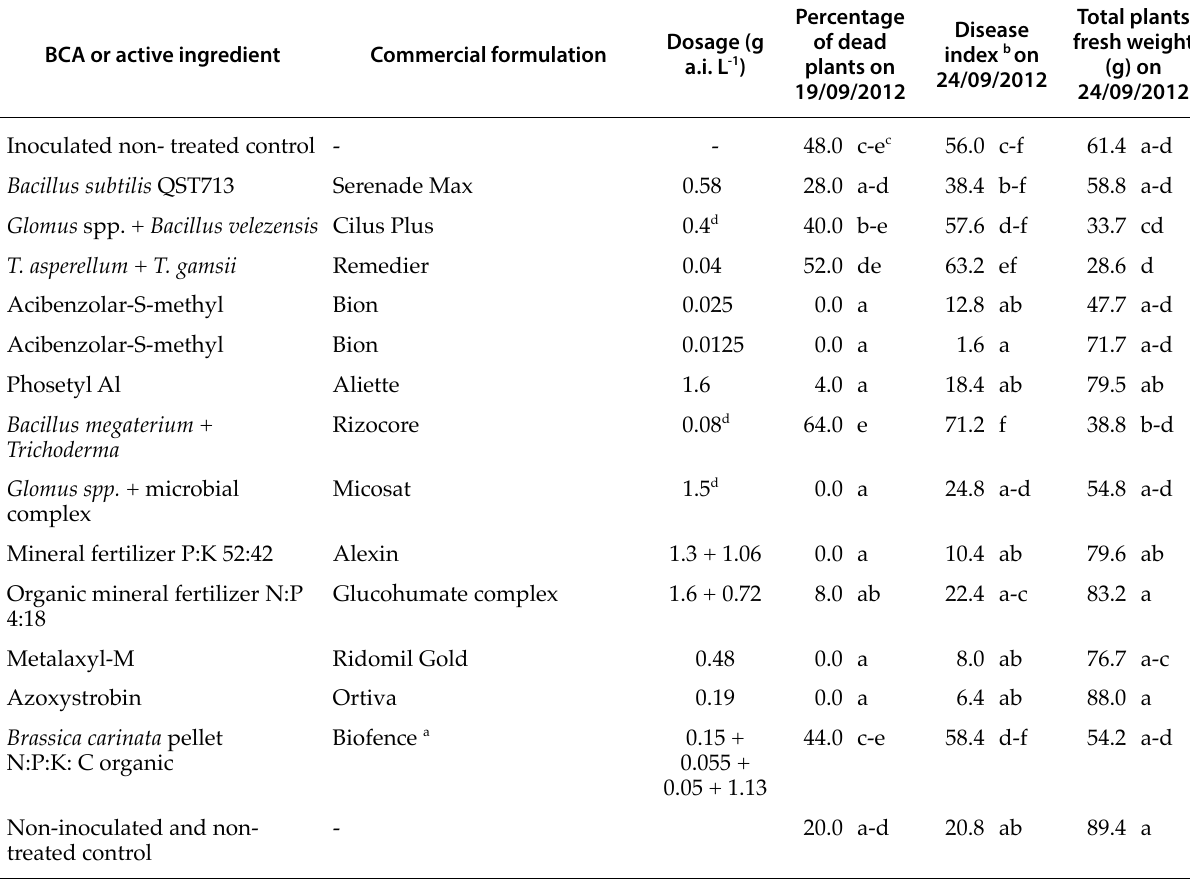
Table 6. Trial 4. Mean proportions of dead plants, mean disease indices (0‒100) and mean total plant fresh weights, for tomato plants receiving different